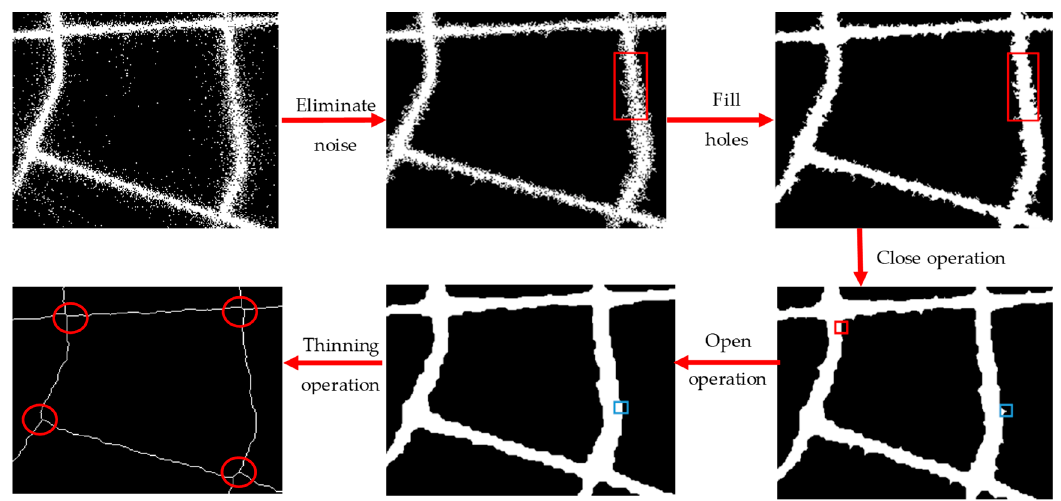
Figure 4. Raster image preprocessing and morphology thinning.